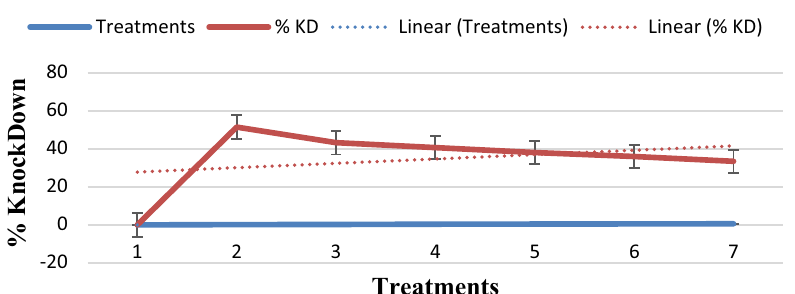
Figure 17. Gene expression of STE12 Gene in P. herbarum against Penicillium